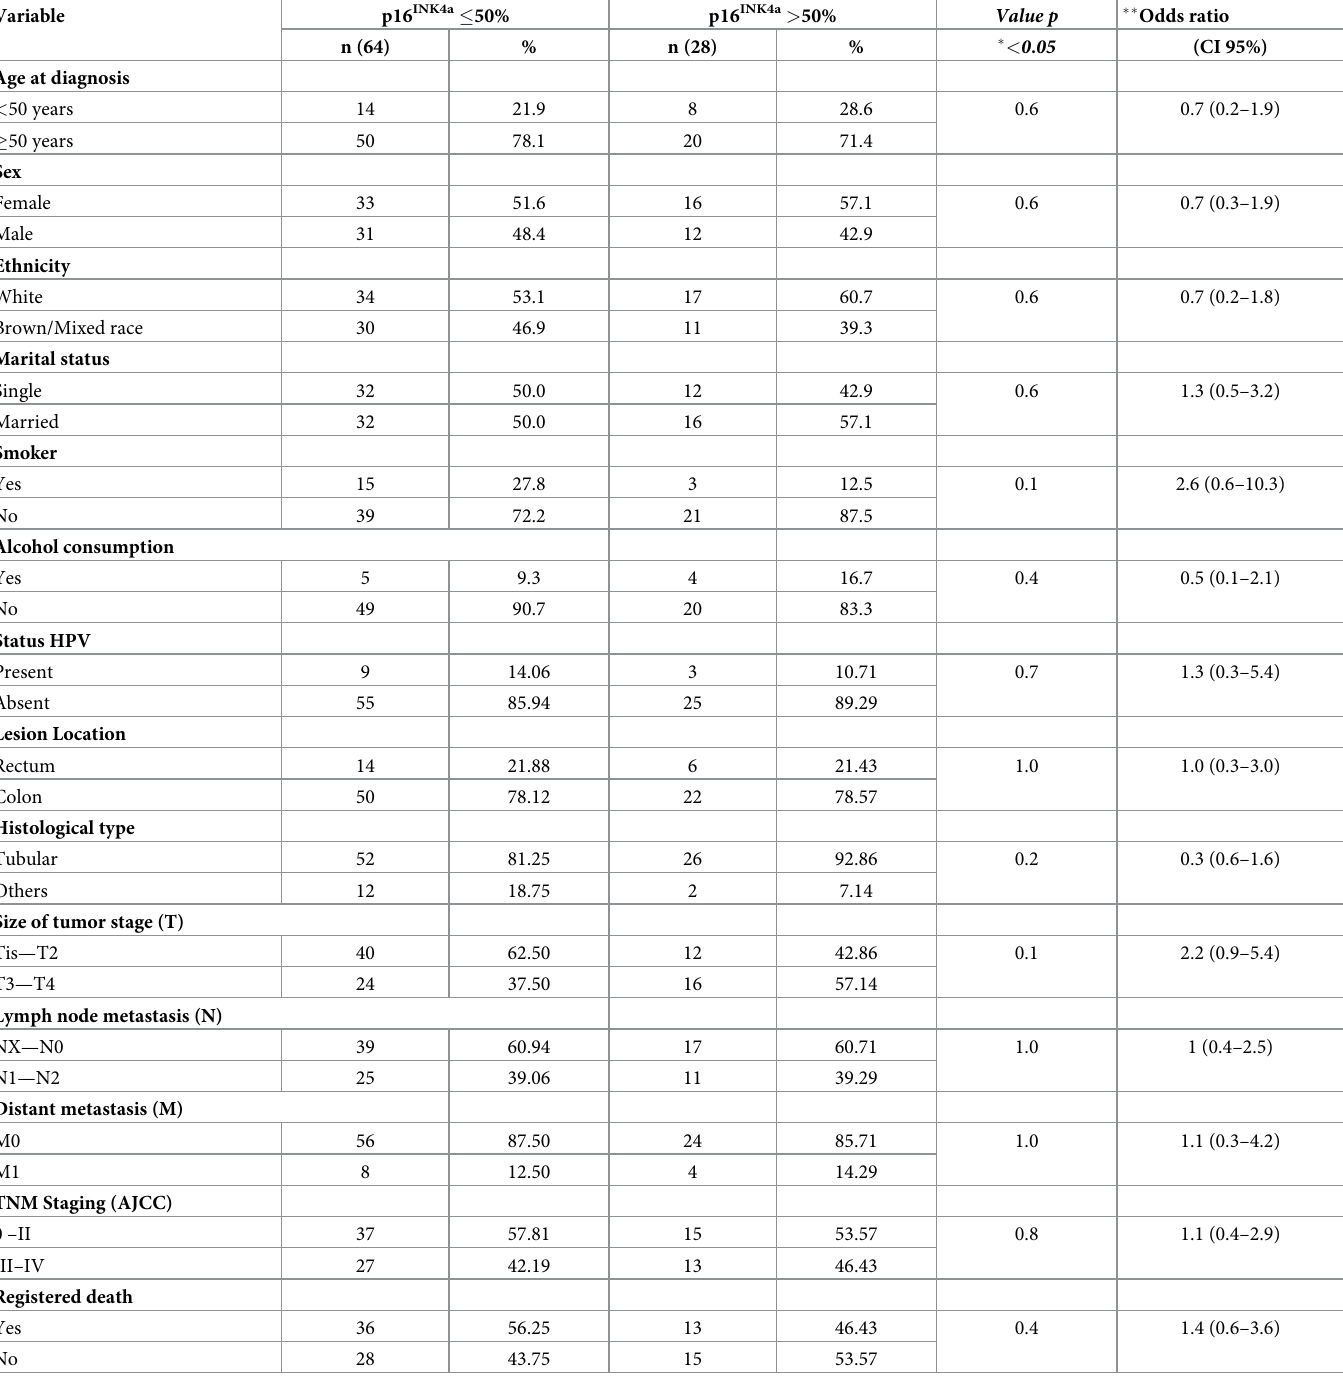
Table 3. Univariate analysis of overexpression ( > 50%) of p16 INK4a associated with the sociodemographic aspects and the clinicopathological aspects in participants diagnosed with colorectal